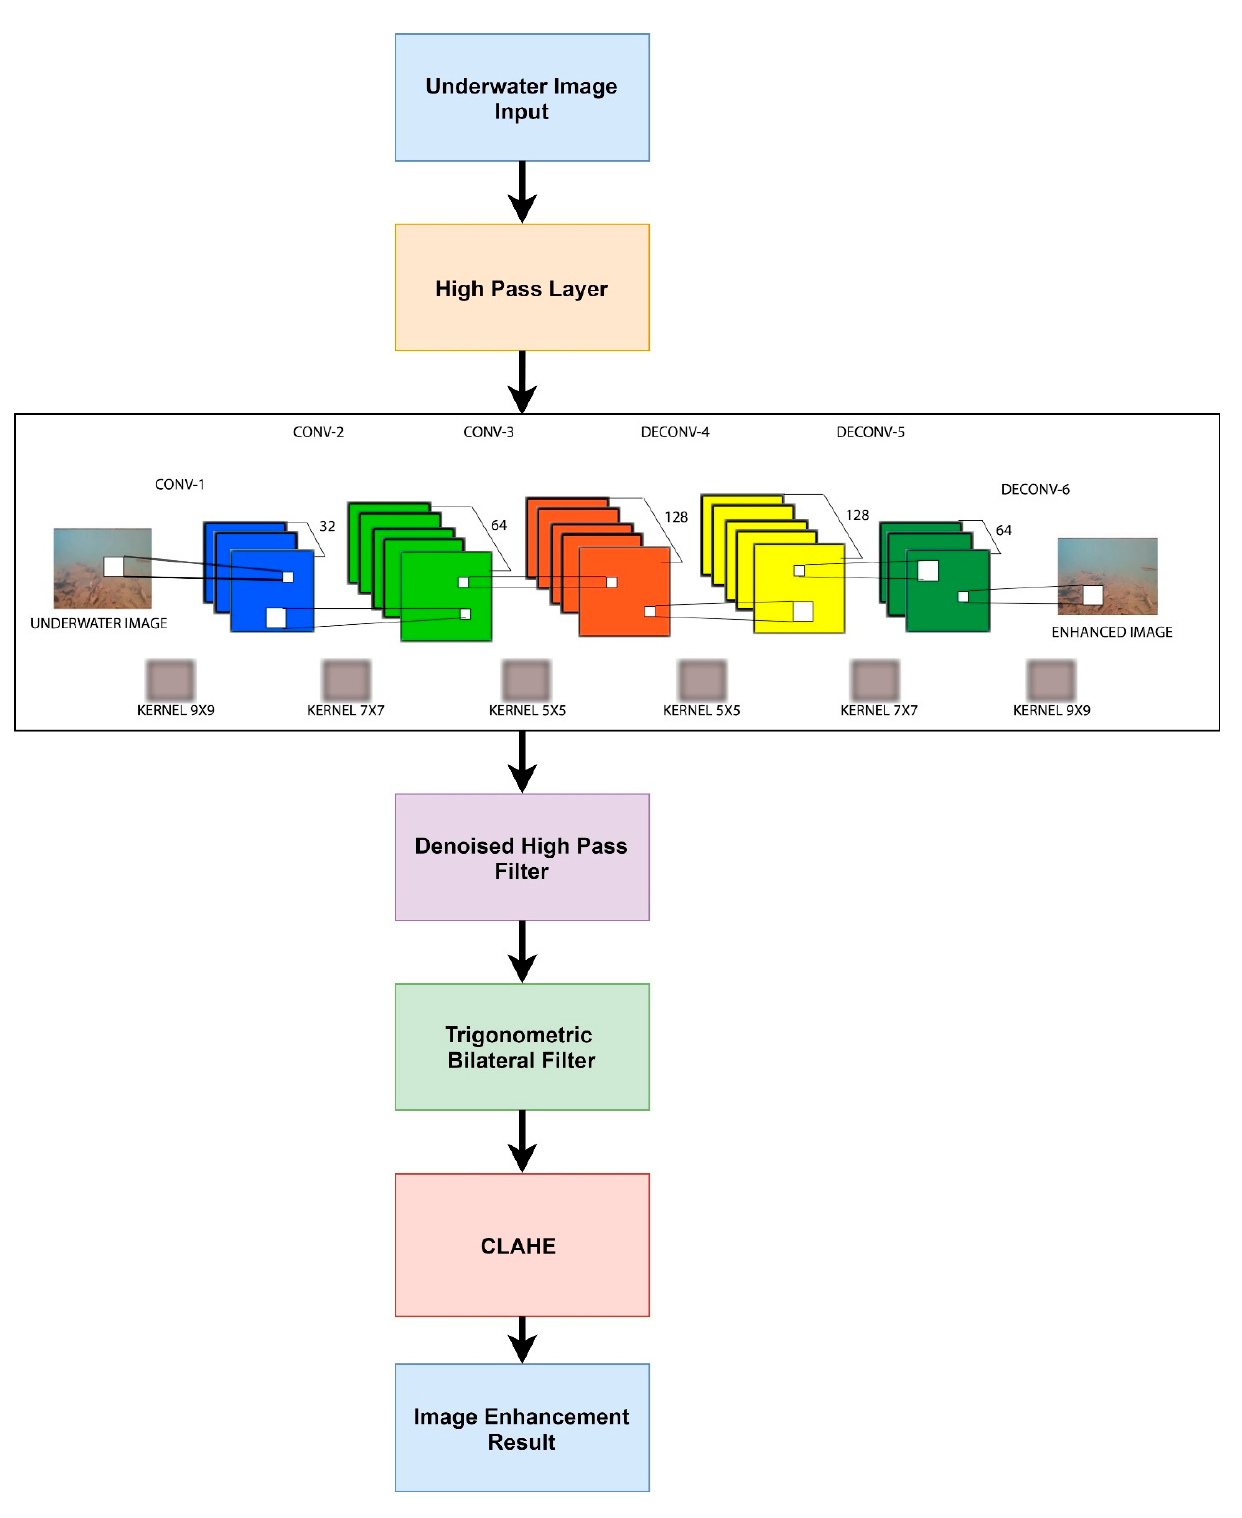
Figure 3. Structure of the proposed noise removal framework.